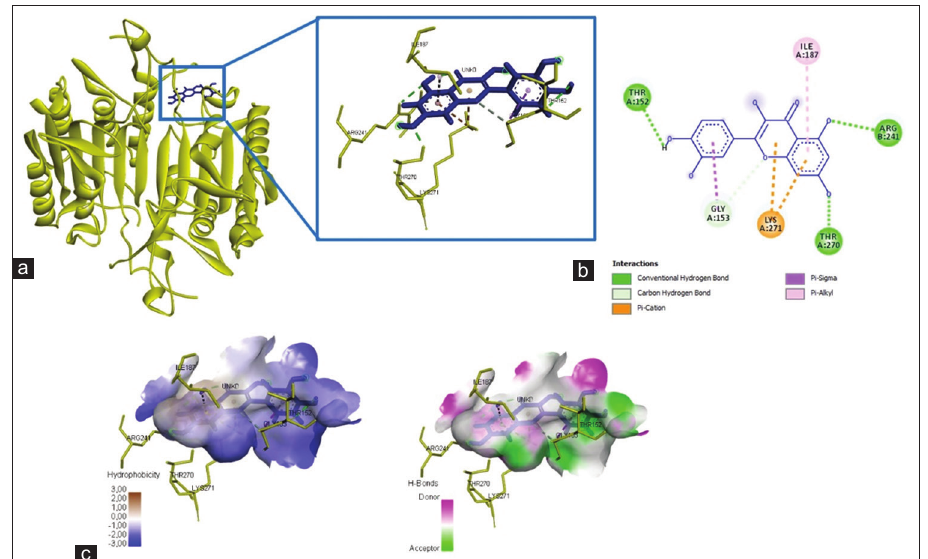
Figure-3: The three-dimensional and two-dimensional structure of the interaction between flavonoid compounds (quercetin) and caspase-3. (a) Three-dimensional structural interaction between flavonoid-ligand compound quercetin (blue) and caspase-3 on the active binding site (yellow). (b) This interaction is built by hydrogen and carbon-hydrogen bonds on the active site of caspase-3, namely, Thr270, Arg241, Thr152, Gly153, Lys271, and Ile187, which can be seen in the two-dimensional (b) and three-dimensional (c) structures.